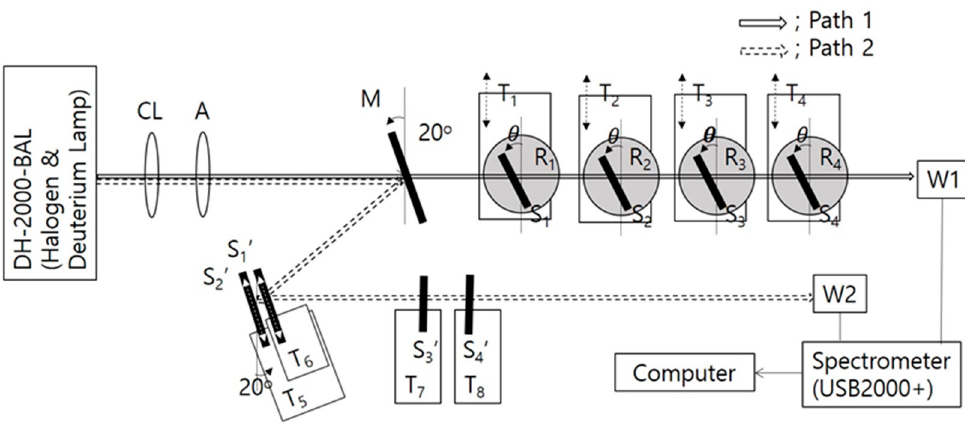
Figure 4. Experimental setup. M, Ag mirror; CL, lens for a collimated beam; A, aperture; R1~R4, rotator; T1~T8, translation stages; 𝑆 (cid:2869) , 𝑆 (cid:2870) , 𝑆 (cid:2871) , 𝑆 (cid:2872) , 𝑆 (cid:2869)(cid:4593) , 𝑆 (cid:2870)(cid:4593) , 𝑆 (cid:2871)(cid:4593) , and 𝑆 (cid:2872)(cid:4593) , R- or L-PCLC cells; and W1 and W2, waveguides of 400 µ m diameter. Depending on the purpose of the device, some of M, R-, or L-PCLC cells could be removed from the setup. To study the function of the circular polarizer and notch filter, Path 1 was used. To study the bandpass filter, Path 2 was used. 𝑆 (cid:2869) , 𝑆 (cid:2870) , 𝑆 (cid:2871) , 𝑆 (cid:2872) ,𝑆 (cid:2869)(cid:4593) , 𝑆 (cid:2870)(cid:4593) , 𝑆 (cid:2871)(cid:4593) ,and 𝑆 (cid:2872)(cid:4593) ,